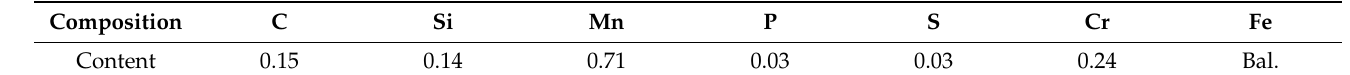
Table 1. Chemical composition (in weight %).